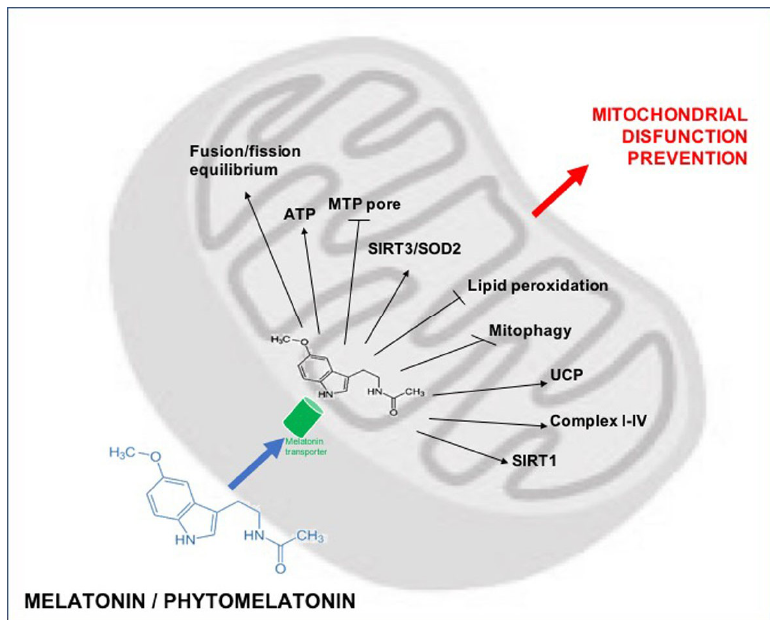
Figure 2. The targeting of melatonin to the mitochondria. Melatonin enters the organelles through specific oligopeptide transporters (PETP 1/2). In these organelles melatonin reduces ROS and prevent lipid peroxidation. Melatonin in mitochondria increase the efficiency of the electron transport chain and improve ATP production. ROS produced by this reaction are directly scavenged by melatonin but are also scavenged by mitochondria SIRT3 and metabolized by SOD2. Melatonin also modulates UCP2 for maintaining the inner mitochondrial membrane potential and prevents opening of the MPT pore. This limit the translocation of cytochrome c in cell cytosol and, so, prevents cellular apoptosis.